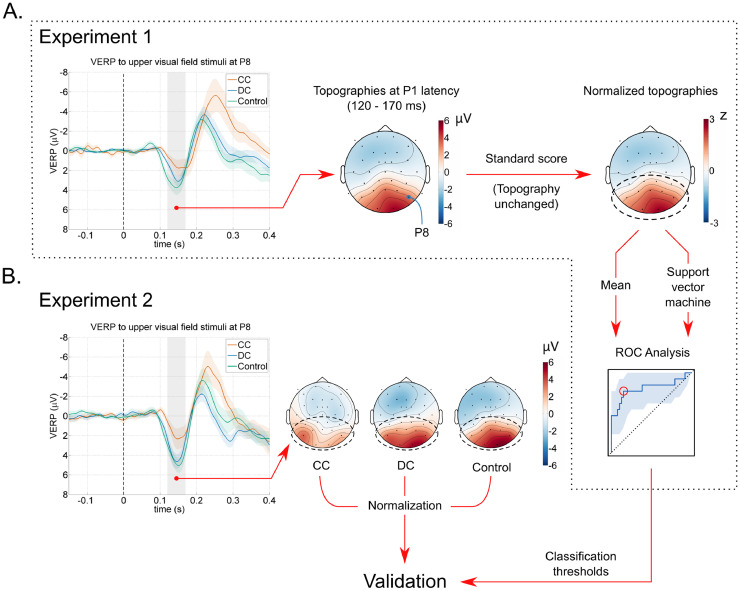
Development and validation of an electrophysiological biomarker for classifying sight recovered bilateral congenital vs. bilateral developmental cataract individuals. A. Visual event-related potentials (VERPs) to upper visual field stimuli from experiment 1 were used for classifier development. The VERPs at electrode P8 is depicted for all three groups. Shaded colored areas show the standard error of the mean. We first extracted the mean P1 amplitude over a 50 ms time range around the average P1 latency (note that electrodes below the nasion-inion “great circle” are depicted outside the head circumference). Thereafter, we normalized the P1 amplitude over the whole electrode montage and calculated the mean value over the posterior electrodes as a biomarker (Mean posterior P1, MPP1). We created an additional biomarker by employing a linear support vector machine to find the optimum linear coefficients for classifying CC individuals (SVMP1). Receiver operating characteristics analysis was used to find optimum threshold values, maximizing the Youden's J parameter. B. Validation of the classification algorithm. VERPs to upper visual field stimuli were obtained from a separate experiment using a different viewing distance. The biomarkers MPP1 and SVMP1 for congenital cataract history were obtained for each individual and classification performance was measured using the thresholds obtained from the first experiment.